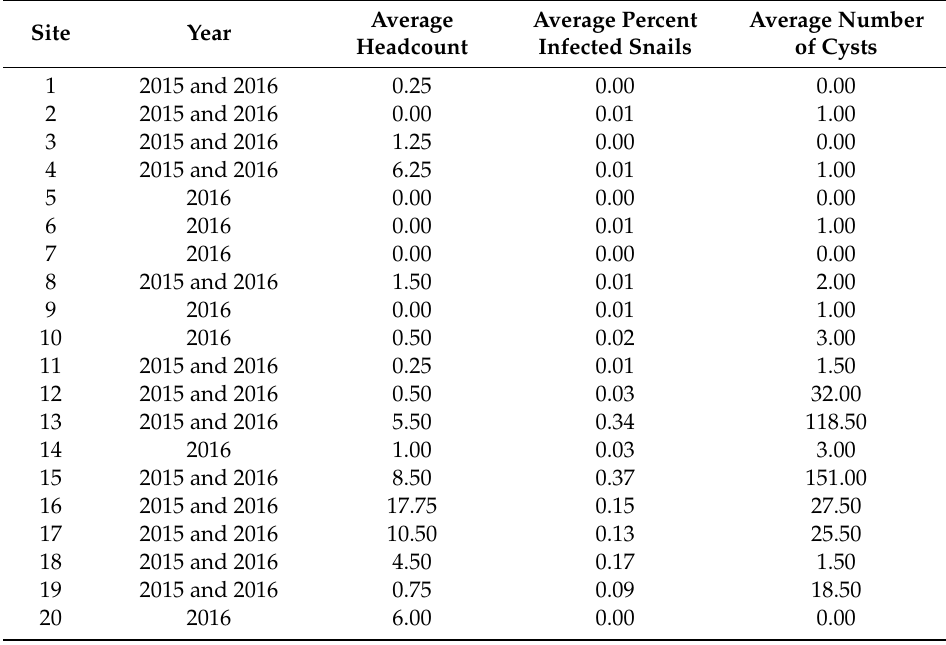
Table 1. Average number of turtles observed from headcount surveys, average percent of snails infected with Pleurogonius malaclemys , and average number of P. malaclemys cysts on mud snails per research site. Site Year